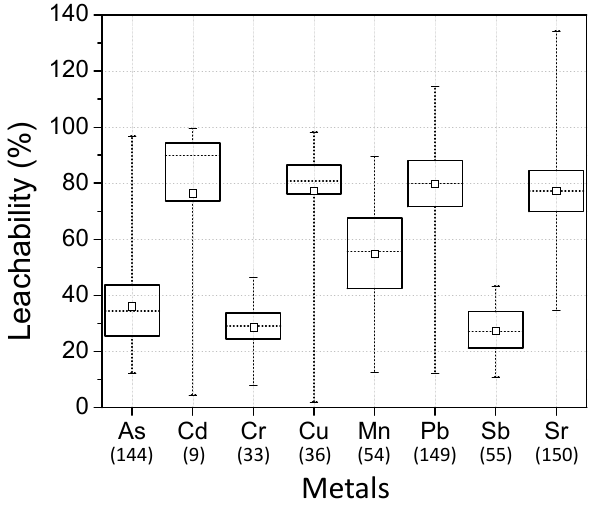
Figure 2. Leachability of metals in settled dust in classrooms. The number of samples, n , is shown in brackets. A percentile box of 25%–75% with minimum and maximum values is shown with the mean value.